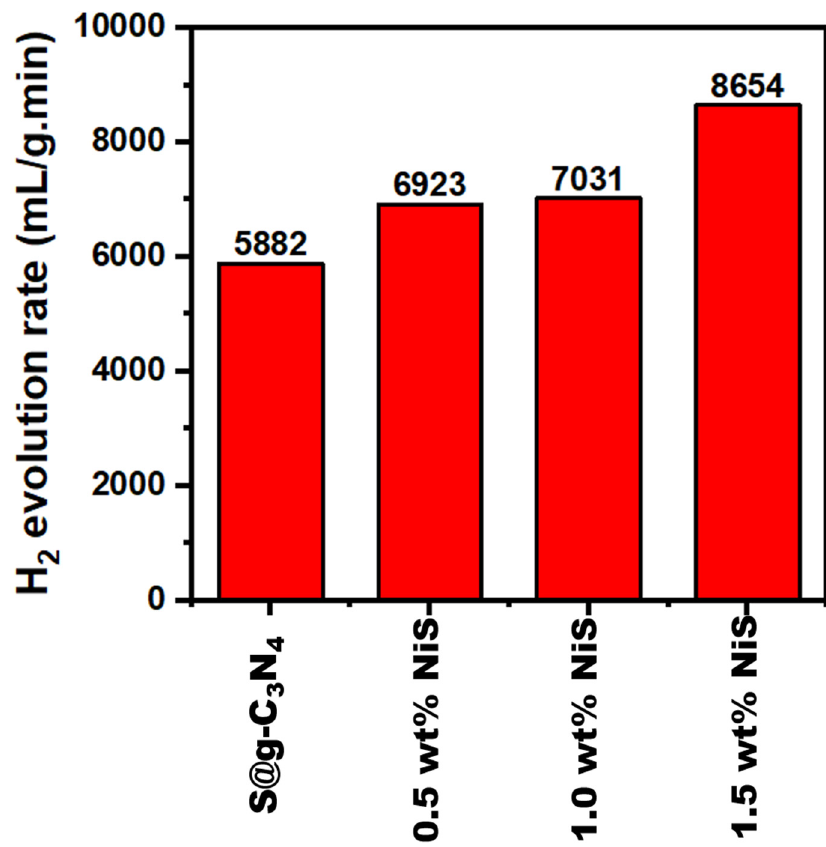
Figure 9. H 2 production rates for S@g-C 3 N 4 and NiS-g-C 3 N 4 nanocomposites.